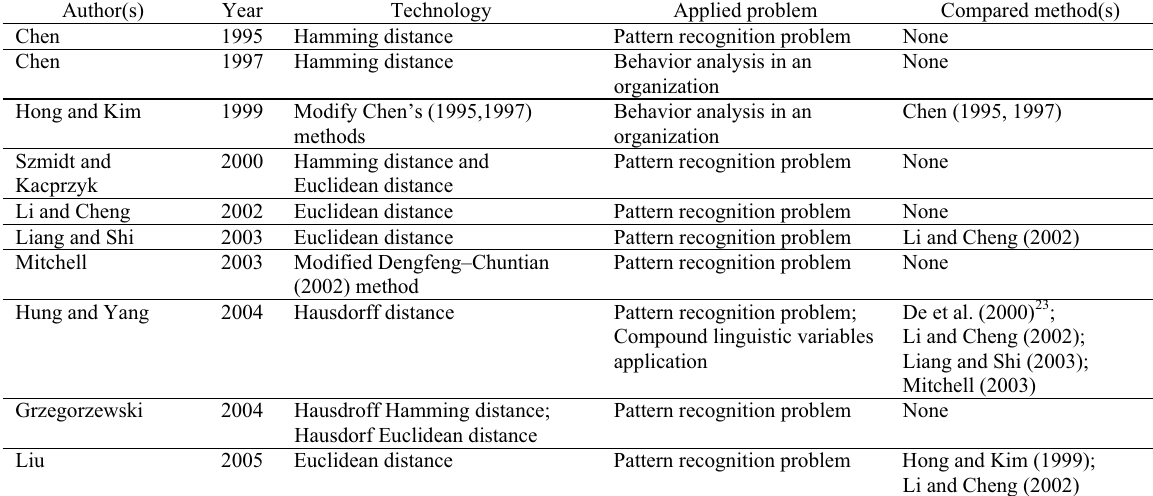
Table 1. Some developments of similarity measure